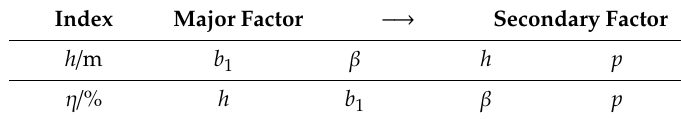
Table 10. The order of influence of the gap geometry parameters on pump performance at 0.6 Q .